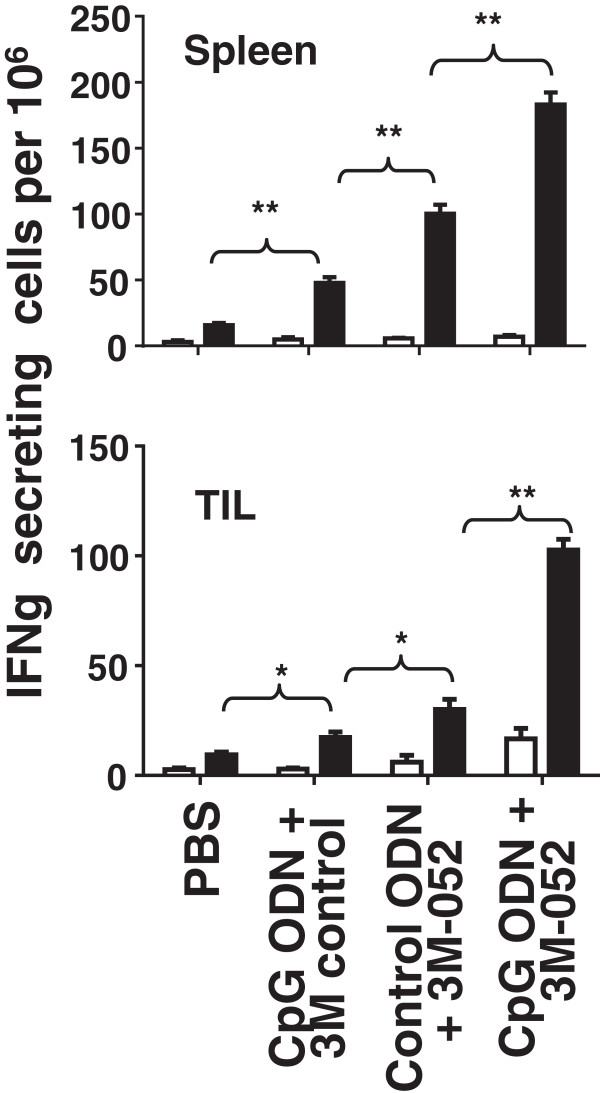
Effect of TLR agonists on tumor-specific CTL. CT26 tumors were implanted into BALB/c mice as described in Figure 
1. Spleen cells and tumor infiltrating lymphocytes were isolated one day after the second treatment, stimulated ex vivo with AH-1 peptide, and monitored for IFNγ secretion by ELIspot assay. Results represent the mean + SD of 6 mice from 2 independent experiments. *, p < 0.05; **, p <0.01.